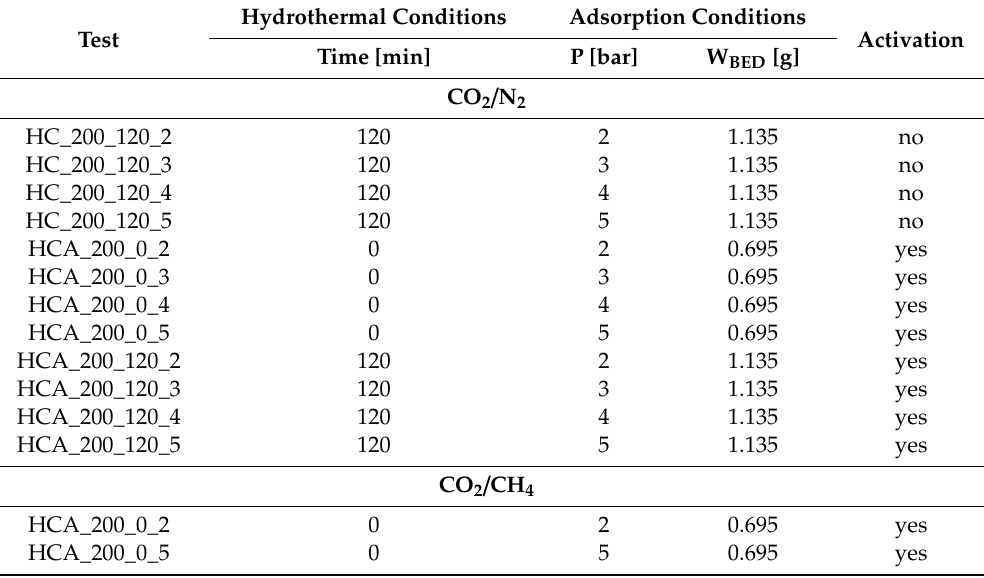
Table 1. Synopsis of tests